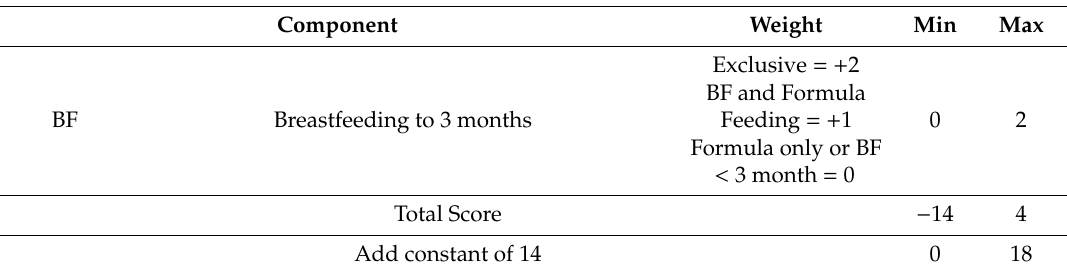
Adapted Infant Food Security Index Used in this Study